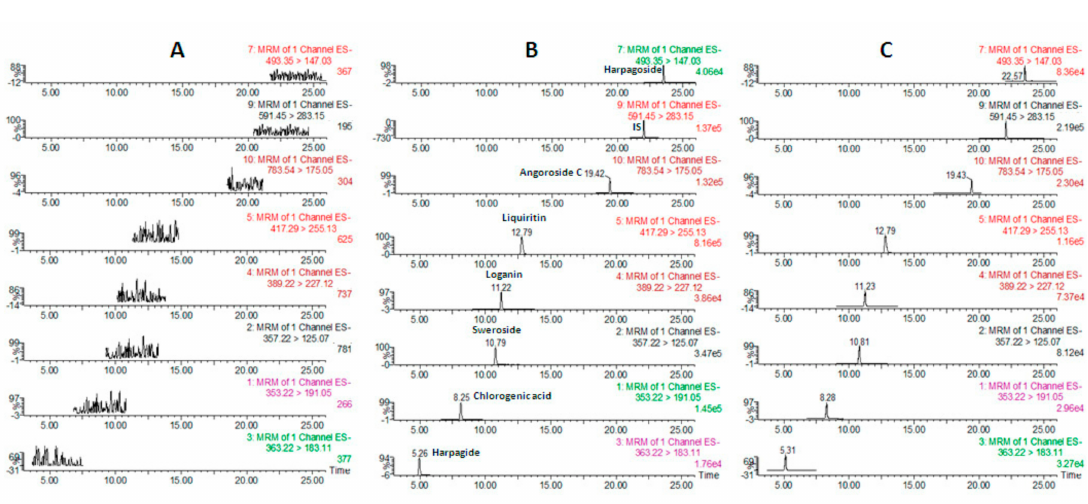
Figure 1. Chromatograms of the analytes and IS in blank plasma ( A ), blank plasma spiked with the analytes and IS ( B ) and a plasma sample from a rat orally administered SimiaoYong’an Decoction(SYD) extract ( C